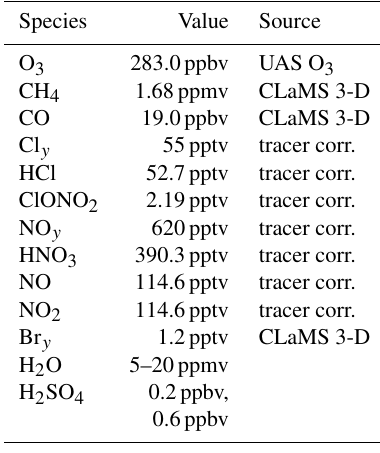
Table B1. Mixing ratios and sources used for initialization of rele- vant trace gases for the MACPEX case. Cl y and NO y values were determined based on tracer–tracer correlations (see text). Initial mixing ratios of ClO x species were assumed to be